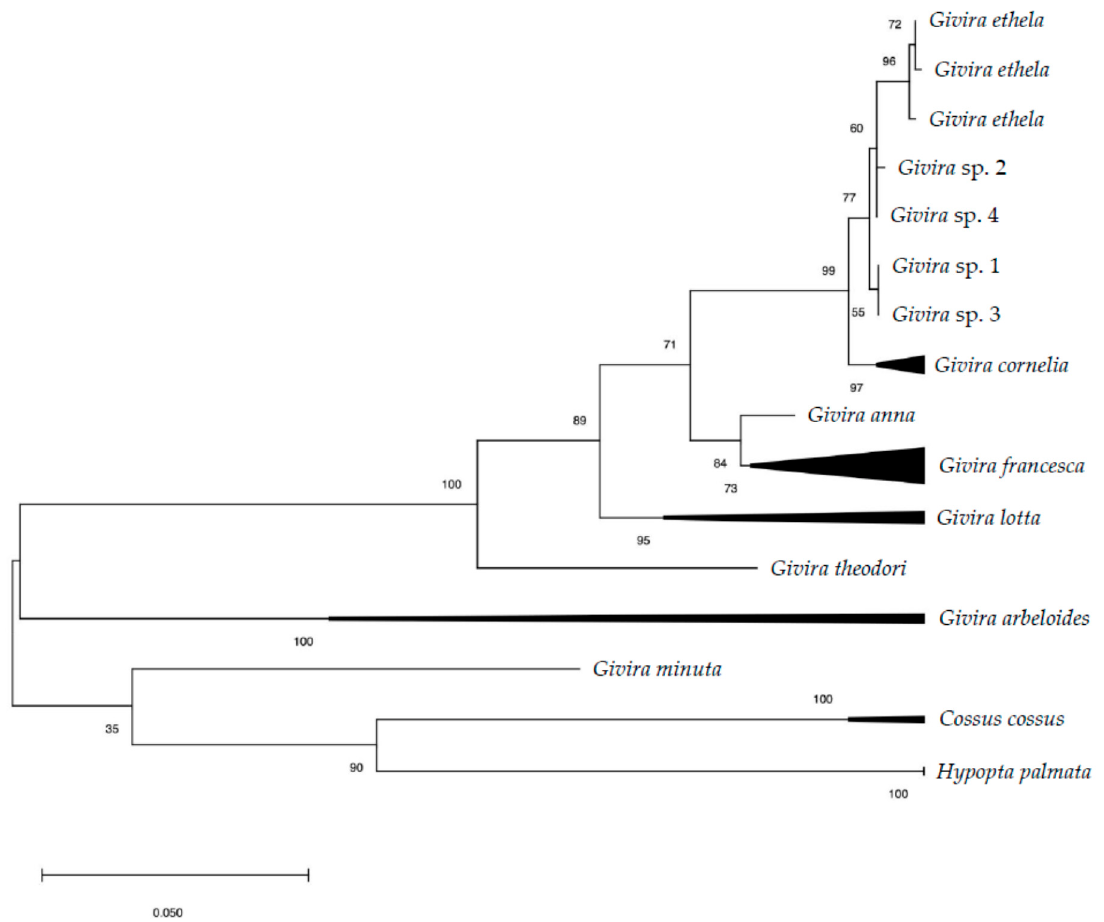
Figure 1. Maximum likelihood (ML) tree based on COI sequences of selected North American Givira species. Numbers on the nodes refer to ML bootstrap values. Hypopta palmata and Cossus cossus are included as outgroups.